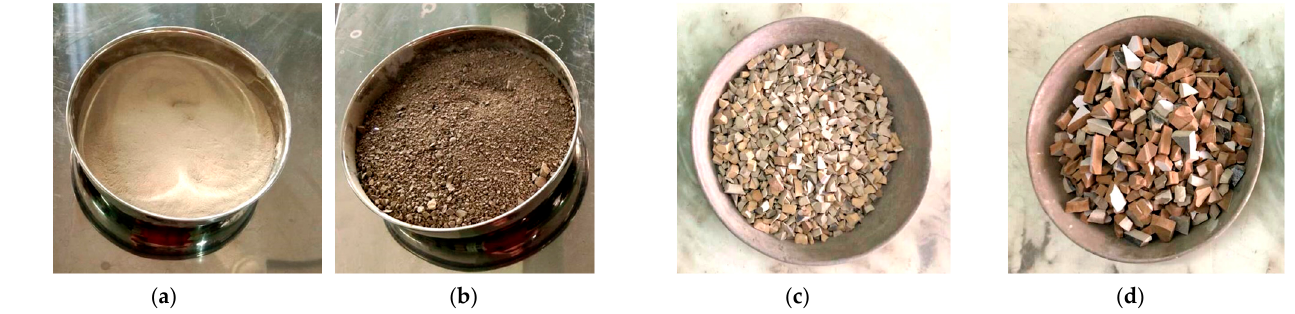
Figure 3. ( a ) commercial cement, ( b ) river sand, ( c ) natural coarse aggregates (NCA)—10 mm, ( d ) natural coarse aggregates (NCA)—20 mm.